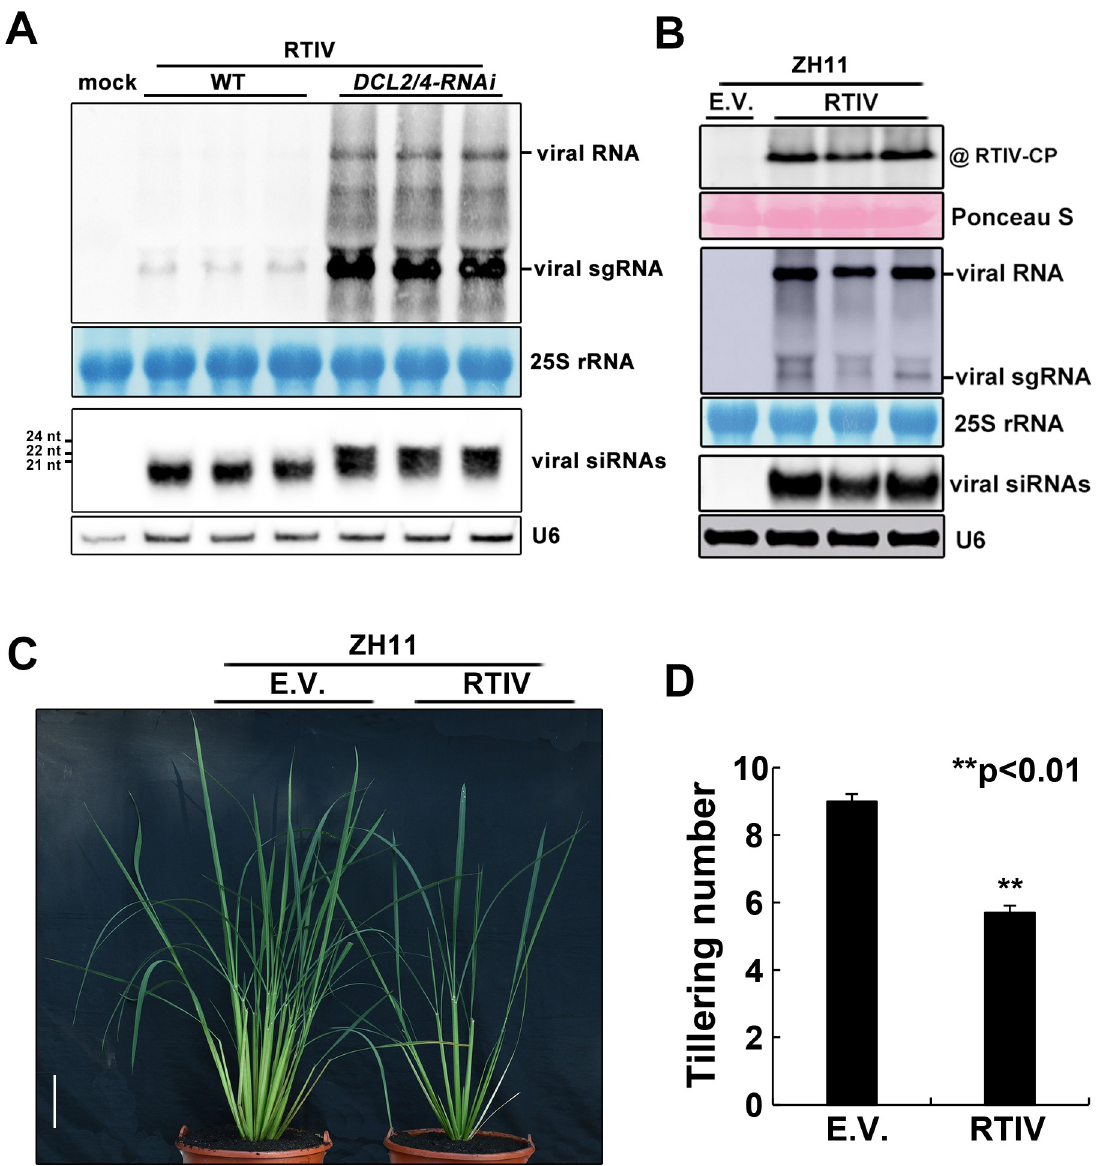
Fig 3. Infection and disease induction of an elite rice variety by cloned RTIV. (A) Northern blot detection of the viral genomic/ subgenomic RNAs and the vsiRNAs in the leaves of wild type and DCL2/4-knockdown N . benthamiana plants infiltrated with pRTIV-Agrobacteria. 25S rRNA was stained or U6 RNA probed in the same membrane to show equal loading. (B) Detection of RTIV CP by Western blotting (top panel), RTIV genomic/subgenomic (sg) RNAs (middle panel) and RTIV siRNAs (bottom panel) by Northern blotting in upper uninoculated leaves of Zhonghua-11 rice plants after Agro-inoculation. Loading control was monitored by ponceau staining, 25S rRNA staining or U6 RNA probing in the same membrane. (C) The reduced tillering symptom of Zhonghua-11 plants ~6 weeks after Agro-inoculation with RTIV. (D) Statistical analysis of tiller numbers of RTIV-infected Zhonghua-11 or mock (n = 30), ** p < 0.01 determined using the Student’s test and mean significant difference. Error bar: standard deviations, Scale bars: represent 10 cm.